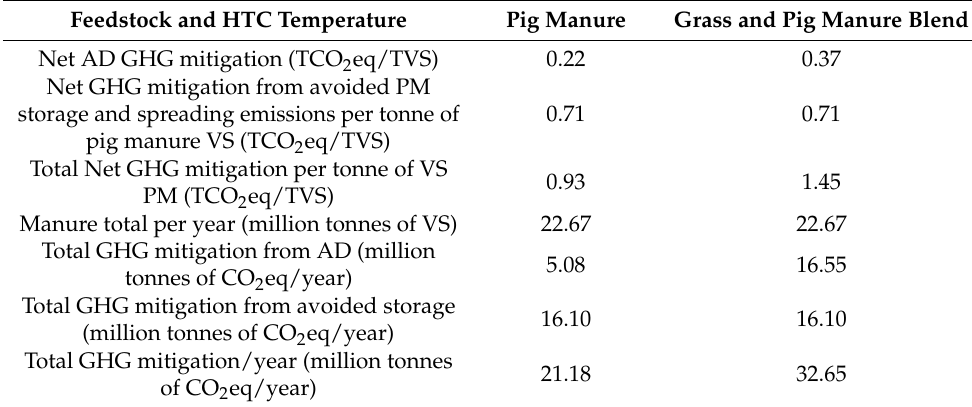
Table 5. EU GHG mitigation from AD of PM and PM-grass blend.